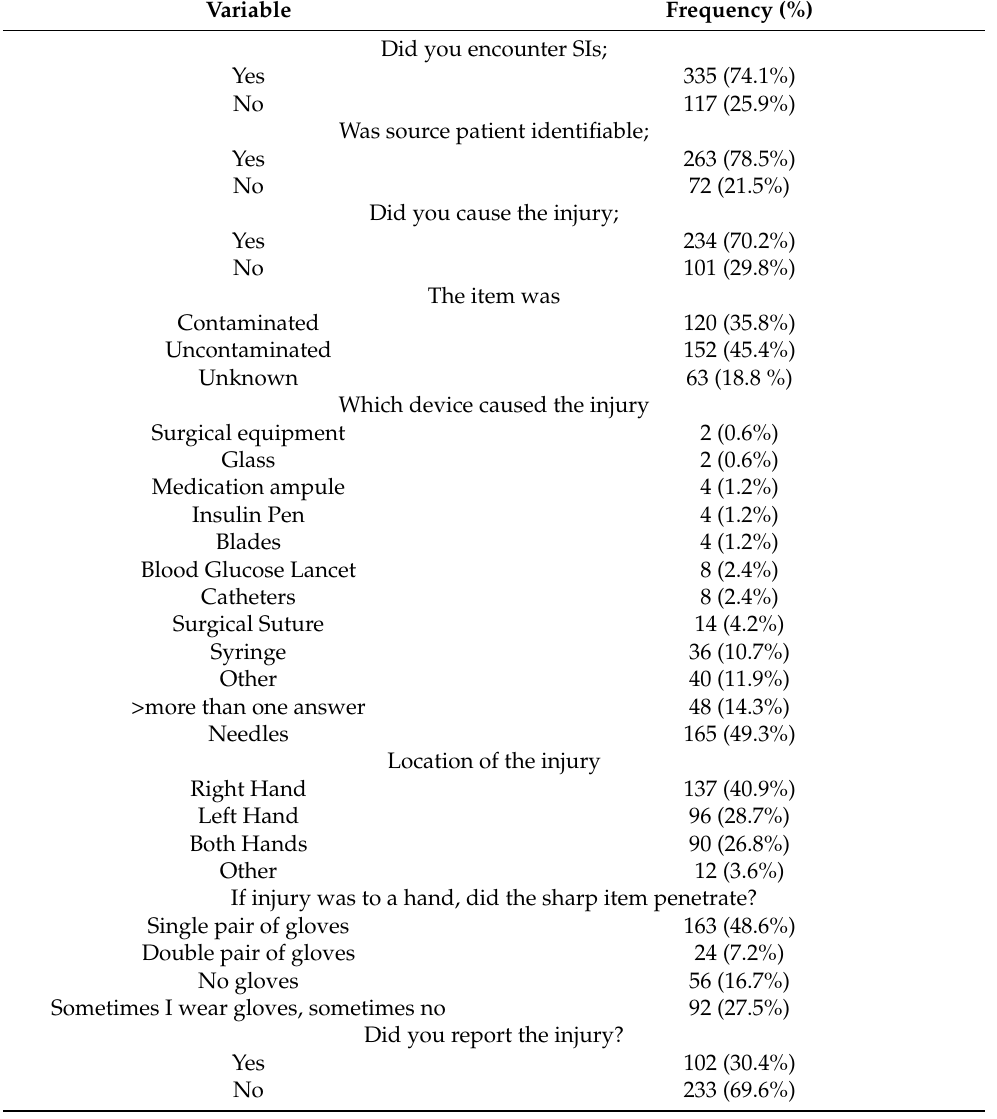
Table 2. SIs are among healthcare